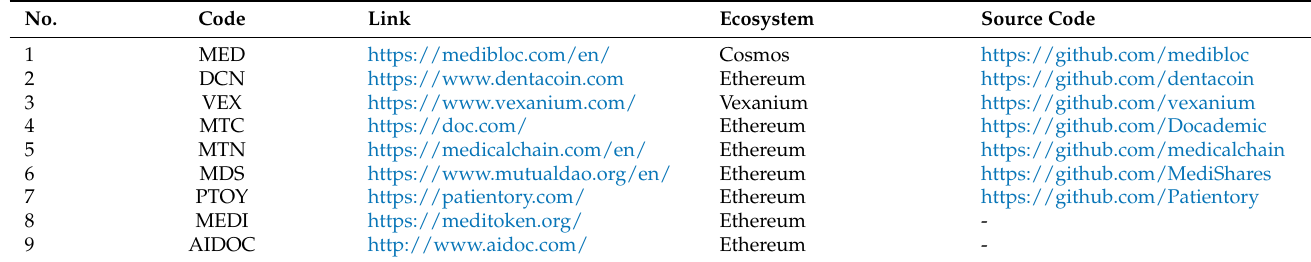
Table 6. Medical project parameters. (accessed on 1 November